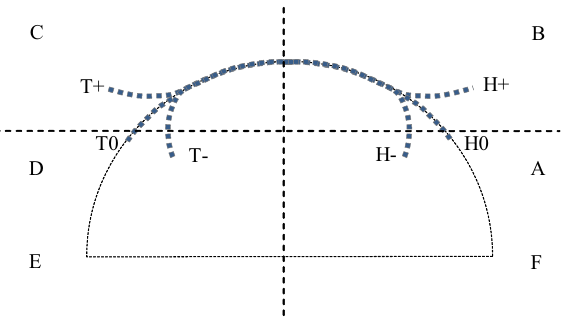
Figure 1. Types of raw data deviations from the semicircle, according to the proposed nomenclature of this study. H stands for head and T stands for tail.